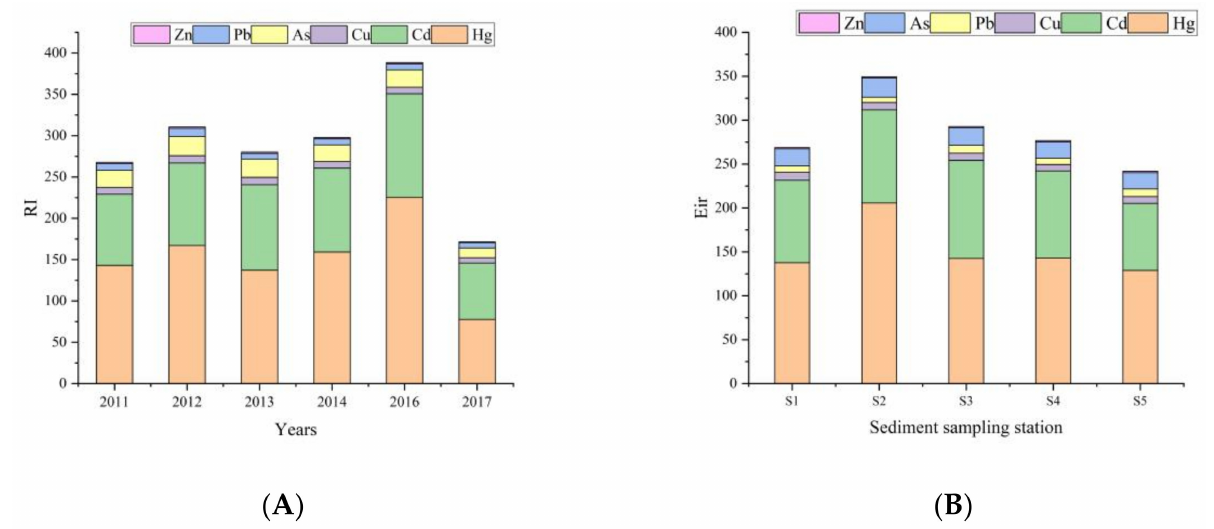
Figure 6. RI of HMs in different years ( A ) and E i r of HMs in different stations ( B